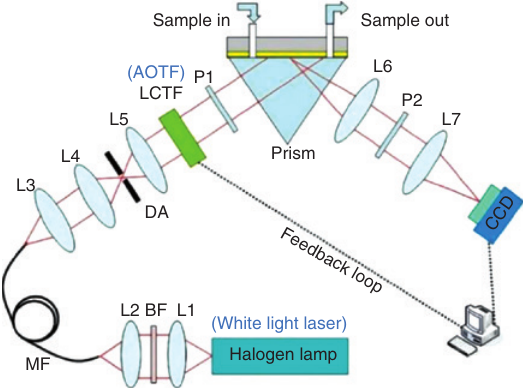
Figure 3: Schematic of our feedback loop-based imaging wave- length SPR system in the Kreschmann configuration. L1, L2, L3, L4, L5, L6, and L7, lenses; MF, multimode fiber; DA, diaphragm aperture; AOTF, acousto-optic tunable filter. P1 and P2, polarizers. Reprinted with permission from Ref.